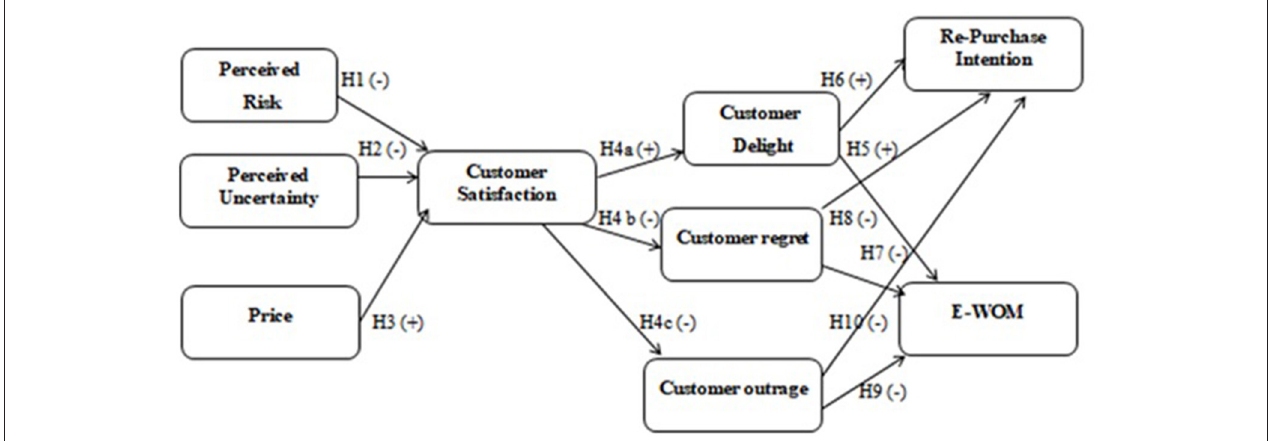
FIGURE 1 | Proposed conceptual